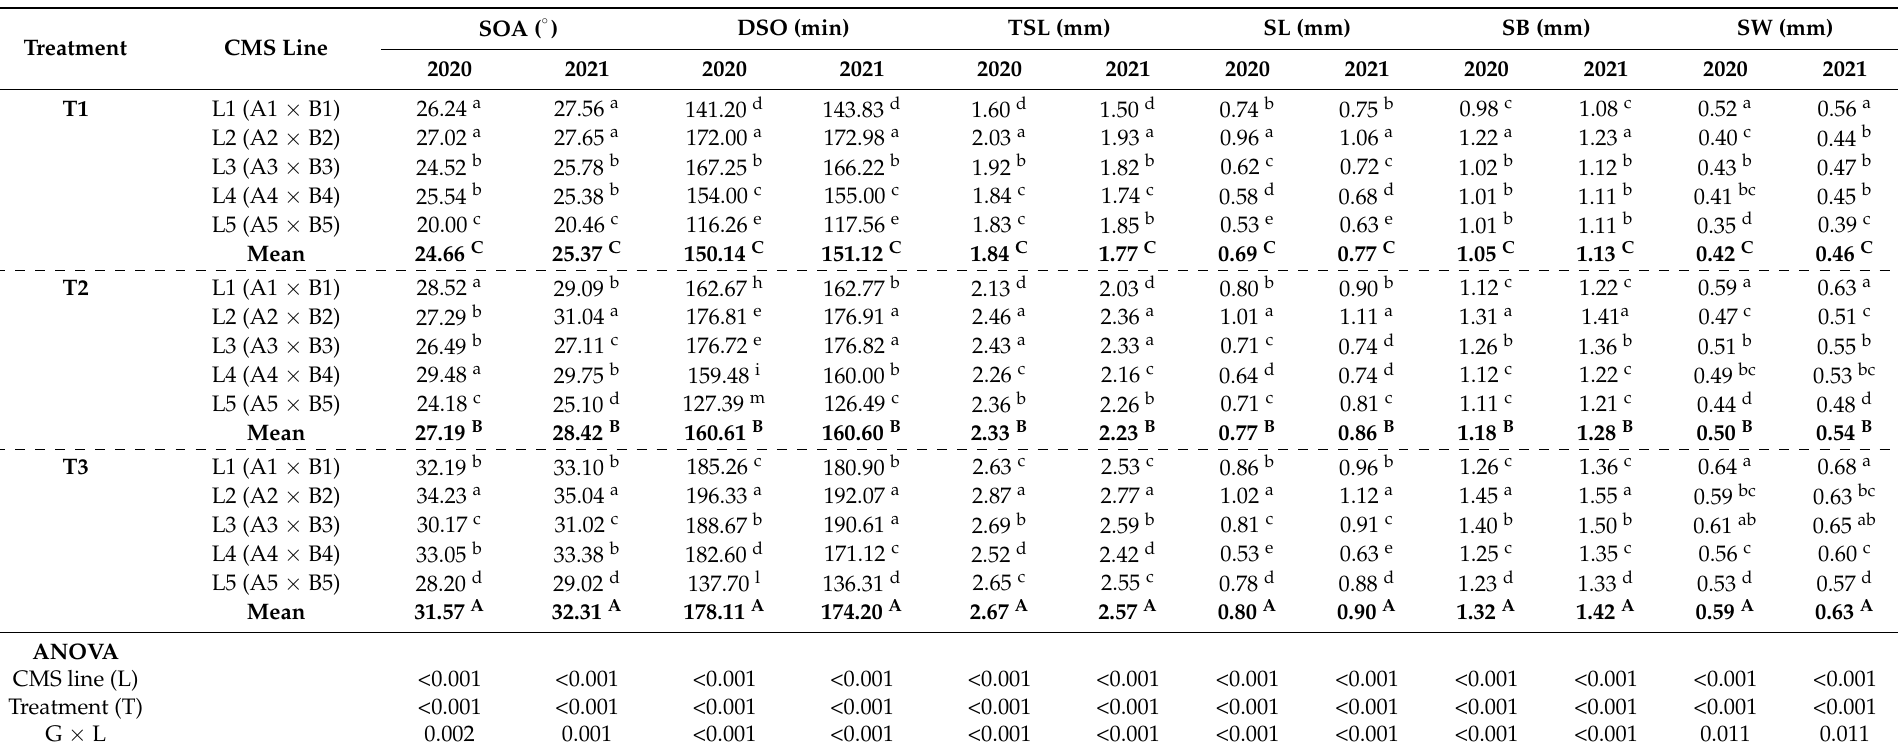
Table 1. Influence of growth regulators on spikelet opening angle (SOA), duration of spikelet opening (DSO), total stigma length (TSL), style length (SL), stigma brush (SB), and stigma width (SW) of five diverse CMS